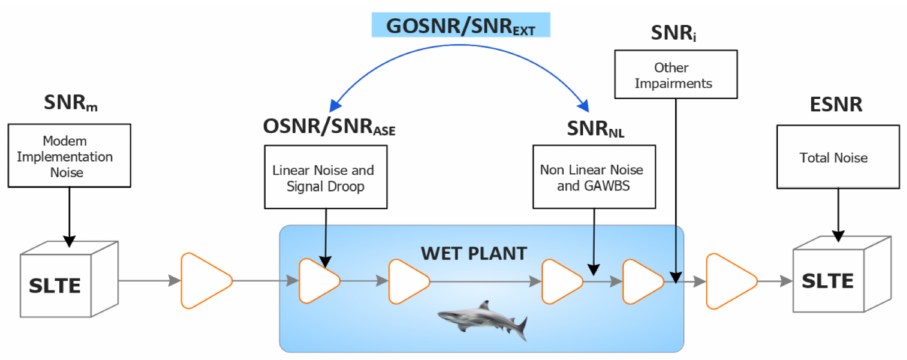
Figure 5. Summation of existing and new cable performance metrics and indication of the exact location where each one of them is measured